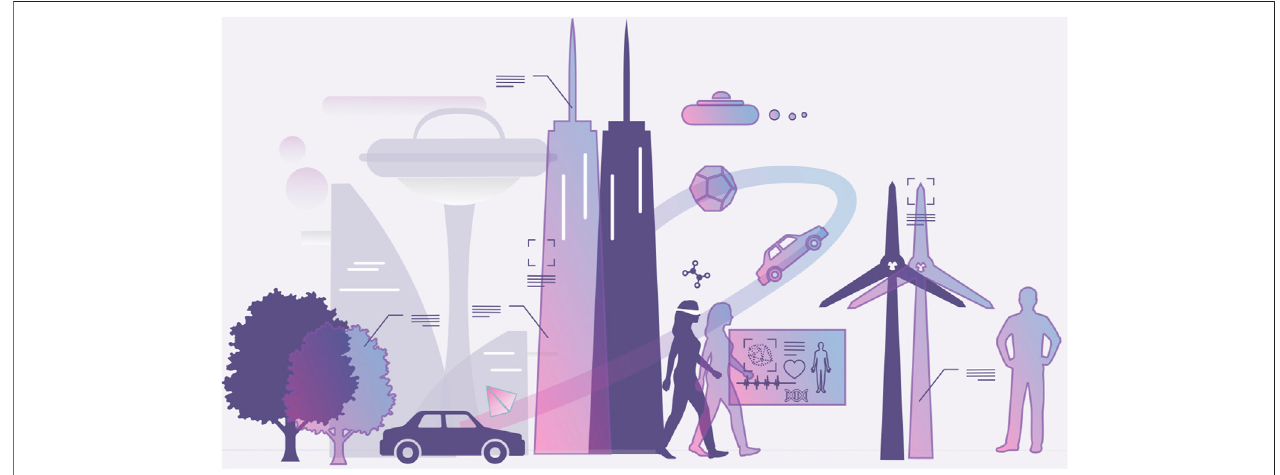
FIGURE 5 | Conceptual image highlighting a world in which the digital twins of people, buildings, vehicles, nature, etc. are integrated into the fabric of daily